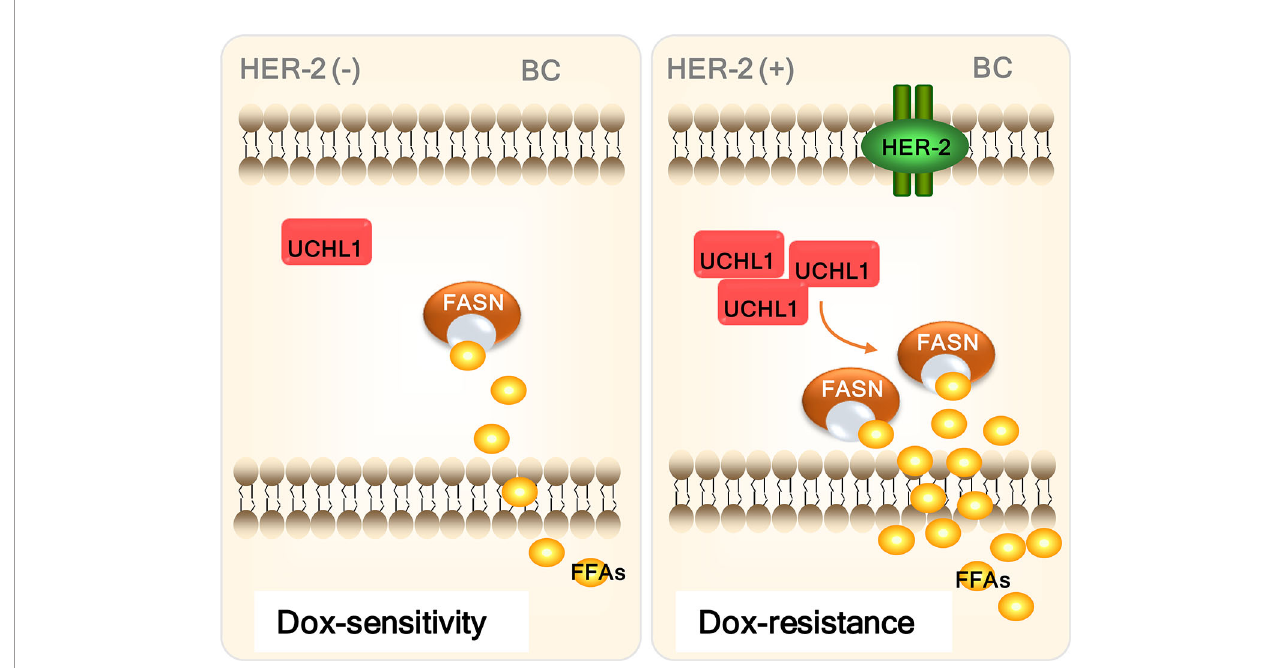
FIGURE 7 | Schematic diagram of the mechanism by which UCHL1 confers DOX-resistance in